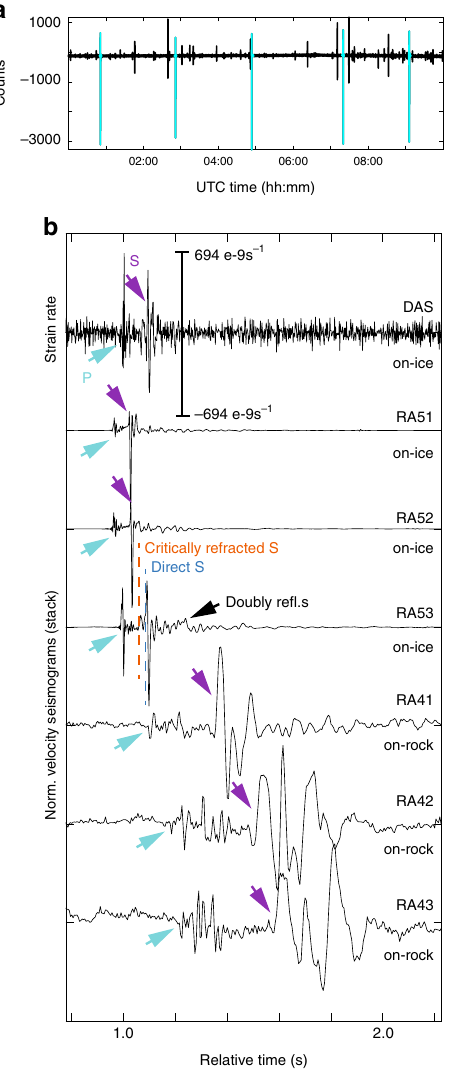
Fig. 3 Stick-slip occurrence and waveforms. a Ten hours long continuous, un fi ltered record of on-ice station RA52. Cyan time series portions are events belonging to the stick-slip multiplet. b Stick-slip seismogram recorded with DAS channel D620 (at southern corner) and stack of 43 on- ice and on-rock vertical seismometer records. Arrivals of P- and S-waves are indicated. For the on-ice stations, the P-arrival is dominated by the direct wave, although a faster wave traveling partially within the underlying bedrock may induce a minor precursory signal. The direct P-wave motion is compressive (upward) in agreement with the double-couple mechanism representing a shear dislocation whose bed-parallel hanging wall slips along the general ice fl ow direction. At on-ice station RA53, direct and indirect wave phases separate and can be identi fi ed with help of the analysis shown in Fig. 4. For the on-rock seismometers, the fi rst arrival cannot be explained with a direct P-wave arrival but instead is a critically refracted P-wave traveling through the bedrock. The polarity of the refracted P-wave is dilatational (down) as this wave samples another quadrant of the double- couple radiation pattern than the direct wave 26